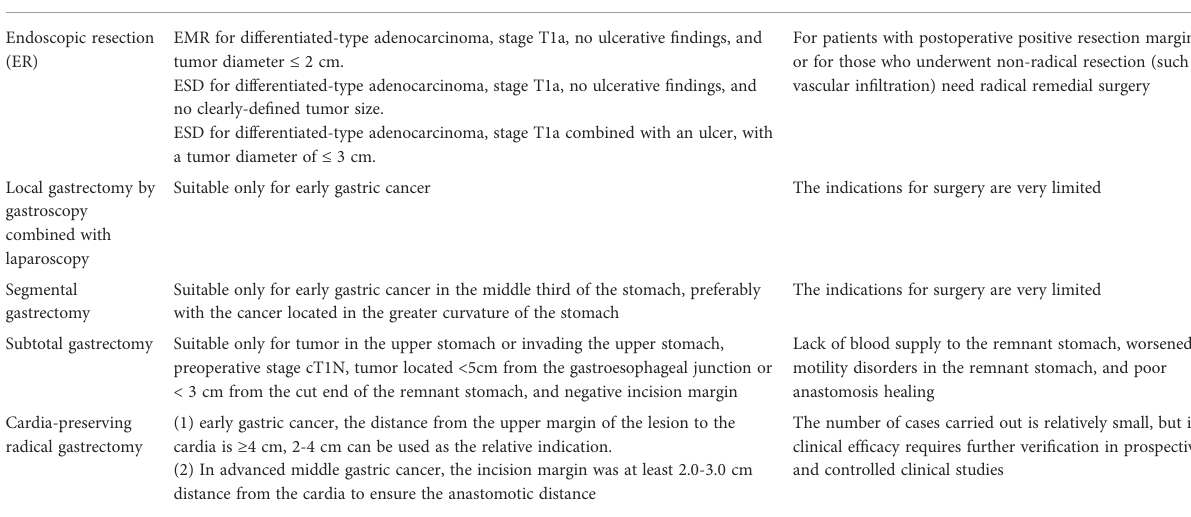
TABLE 2 Function-preserving gastrectomy. Method of operation